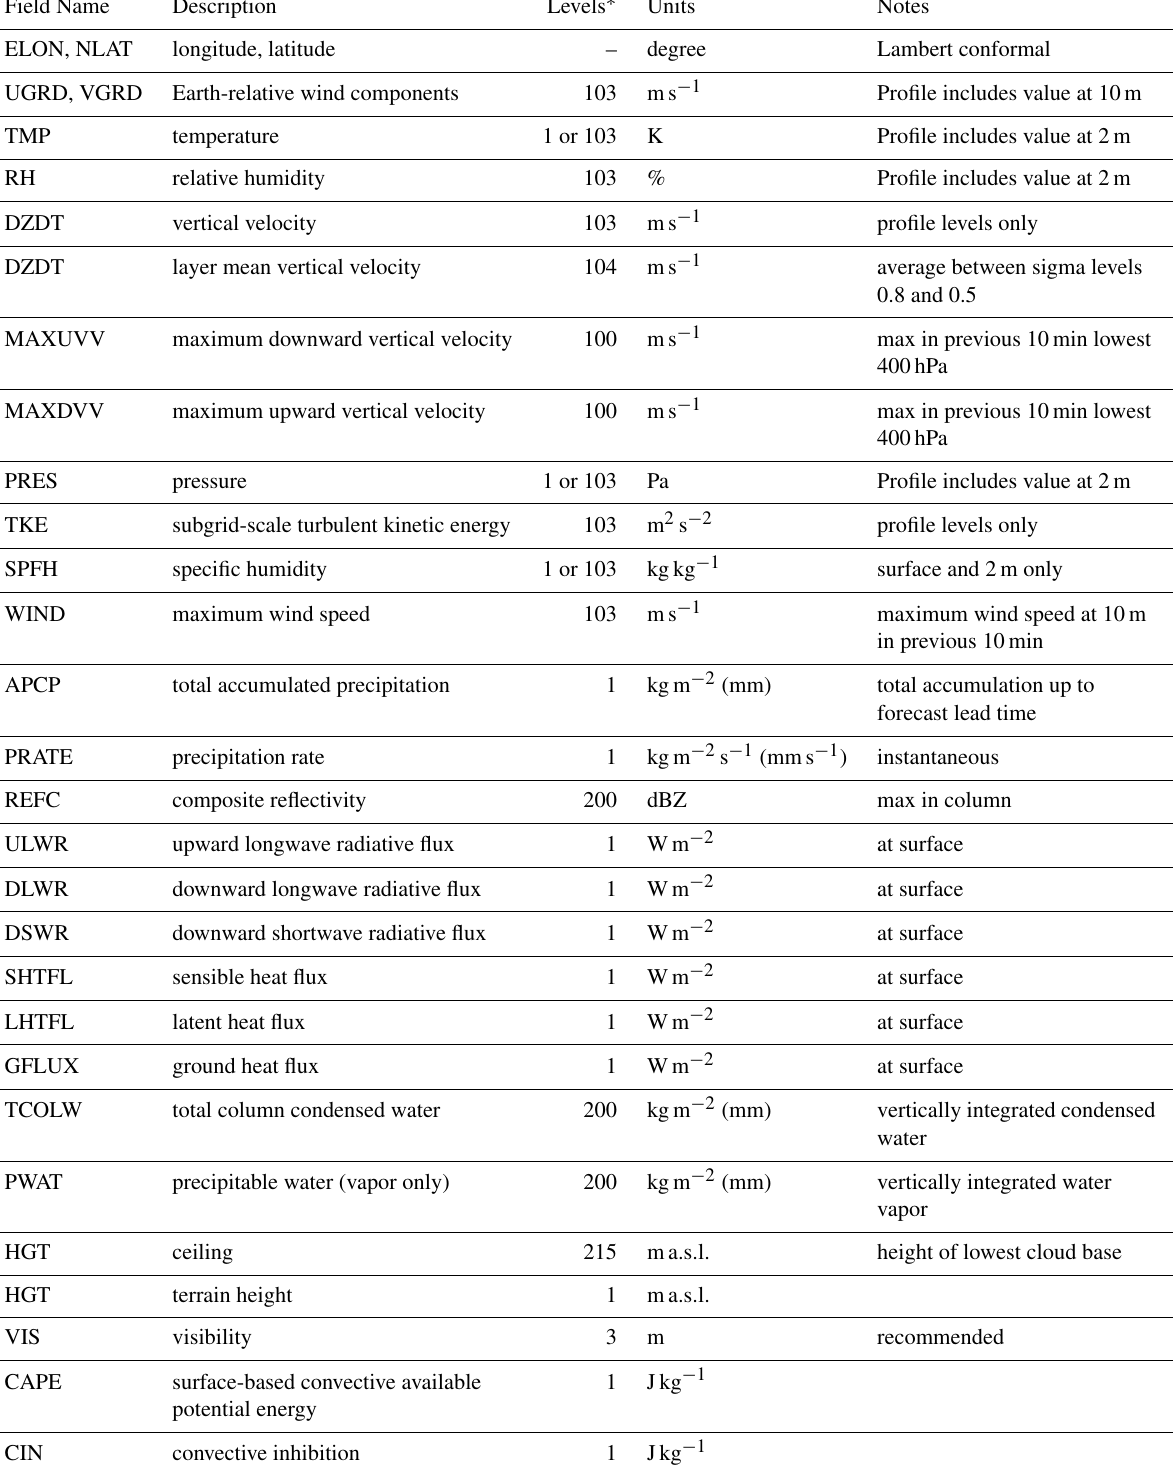
Table 2. Description of gridded output variables in Grib2